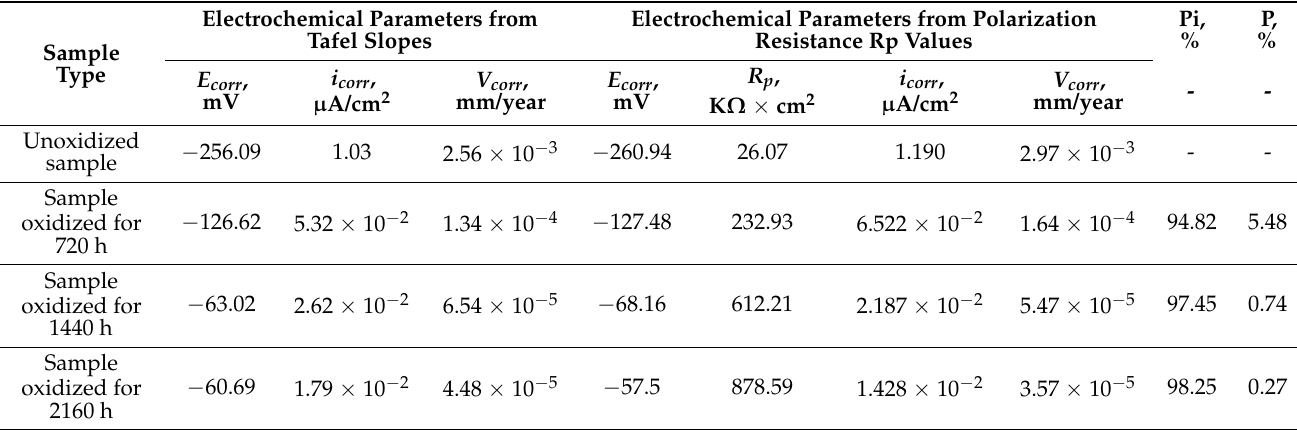
Table 7. Electrochemical parameters from Tafel slopes and polarization resistance for unoxidized and oxidized samples in water at a supercritical temperature (550 ◦ C and 250 atm).